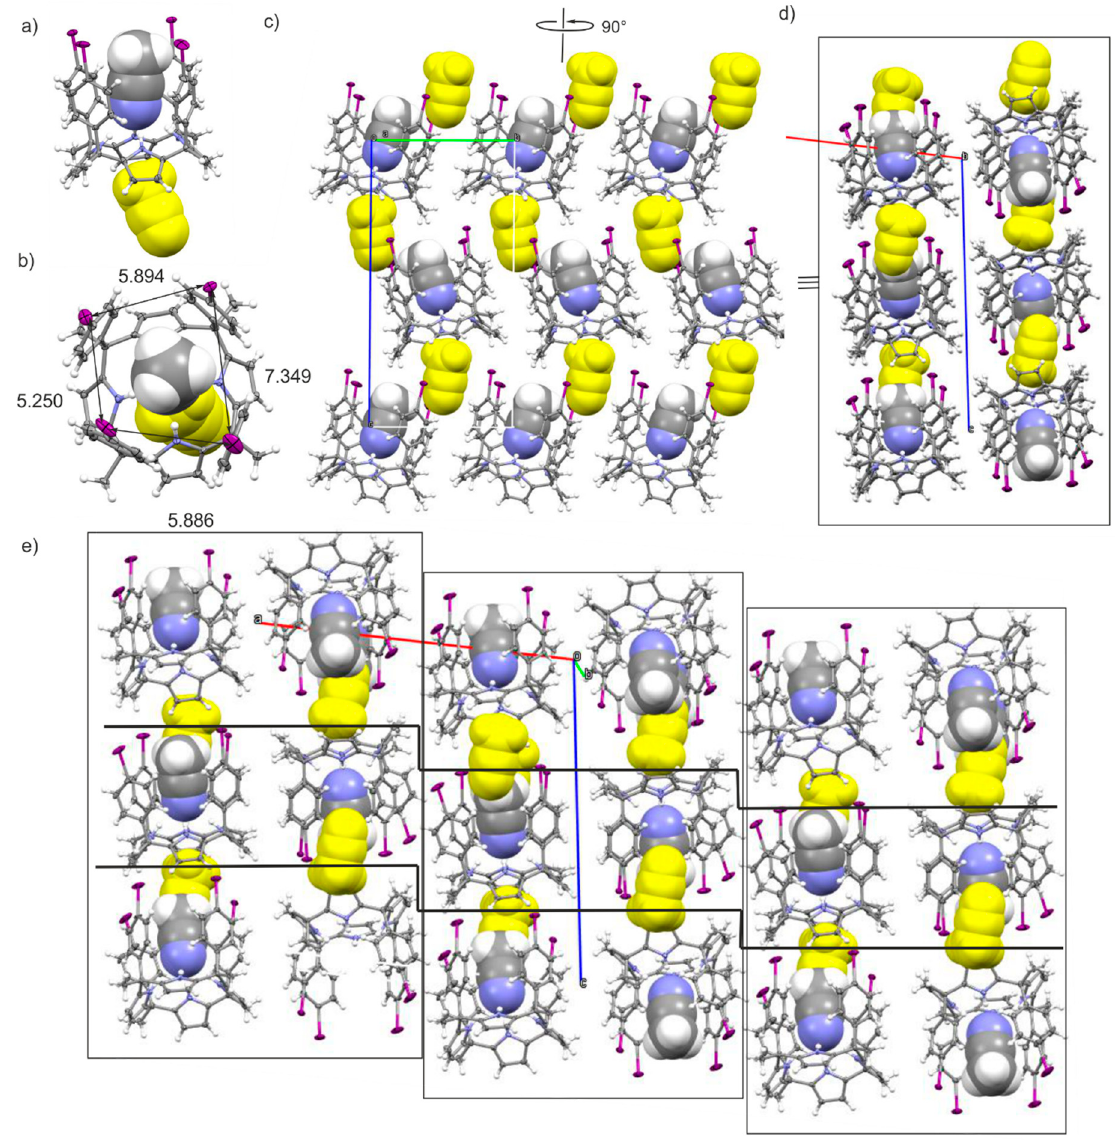
Figure 4. Side ( a ) and top ( b ) views of the X-ray asymmetric unit of solvate C . Distances in Å; ( c ) Restricted packing of the layer formed by the pilling of rods of unidirectional-oriented CH 3 CN@calix[4]pyrrole inclusion complexes mediated by sandwiched ACN molecules; ( d ) 90° rotated view of ( c ) showing the packing of two adjacent layers with the CH 3 CN@calix[4]pyrrole oriented in opposite directions (see text for details); ( e ) Restricted packing of the acetonitrile solvate, C . The stair-like 2D layers formed by the CH 3 CN@calix[4]pyrroles when viewed from the b axis is highlighted between solid lines. Rectangles are used to define the blocks of perfectly aligned dimeric layers depicted in ( d ). The calix[4]pyrroles are shown in stick representation. The two bound ACN molecules are shown as space fill models with the externally bound ACN in yellow color. Thermal ellipsoids for C, N and I atoms set at 50% probability; H atoms are shown as spheres of 0.20 Å diameter.